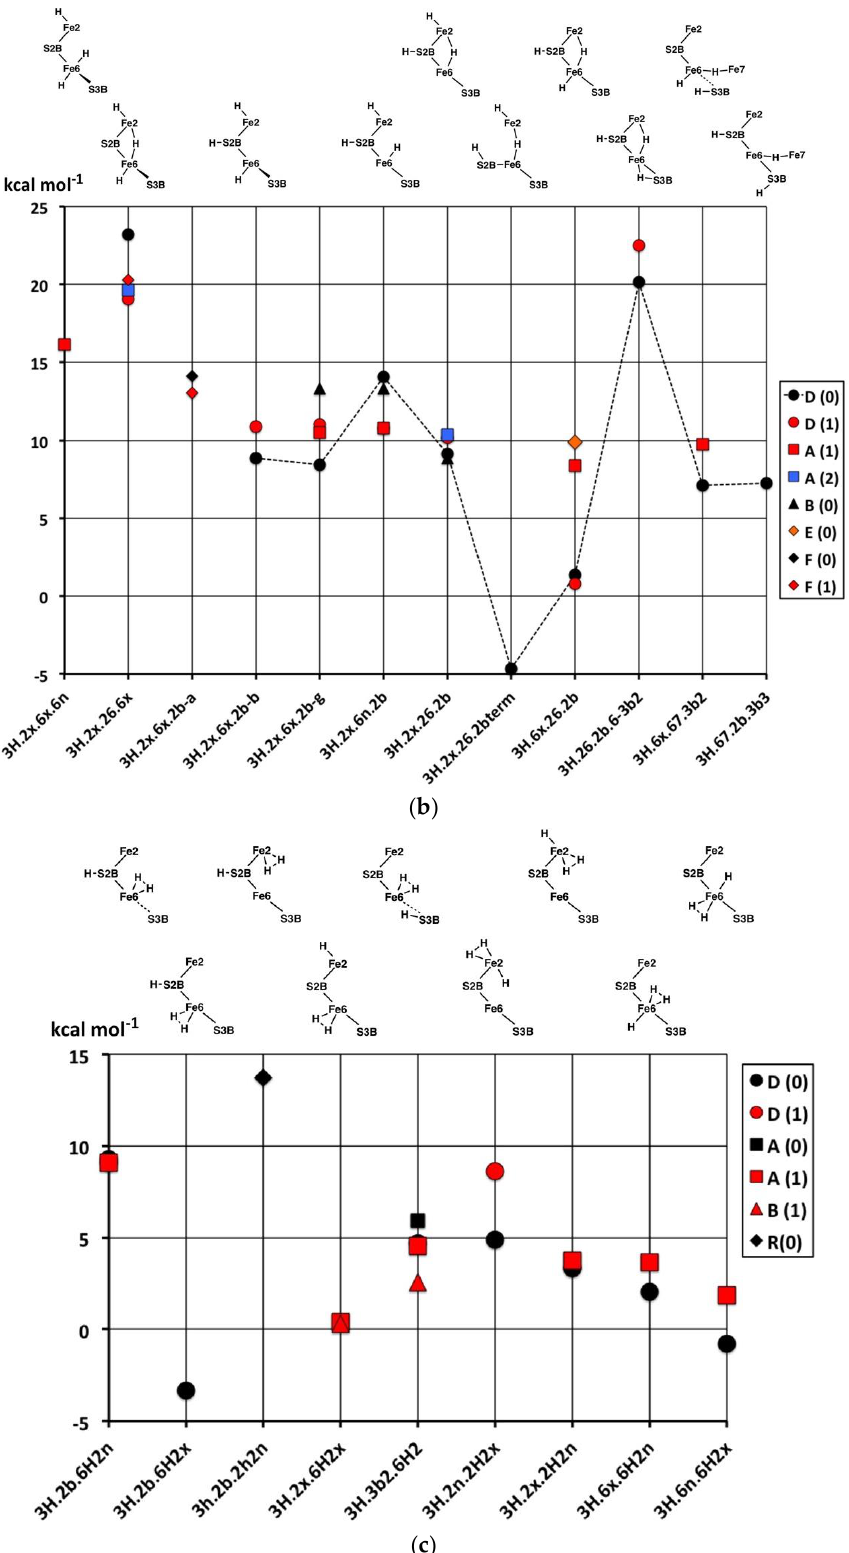
Figure 8. Relative potential energies (kcal mol −1 ) of the optimised structures with three H atoms bonded to FeMo-co, in their most stable electronic/spin states. ( a – c ) Energies for the sequences of structures in Figure 7a–c. The three parts have the same energy reference. The tie lines are included only as a visual guide and have no physical significance.